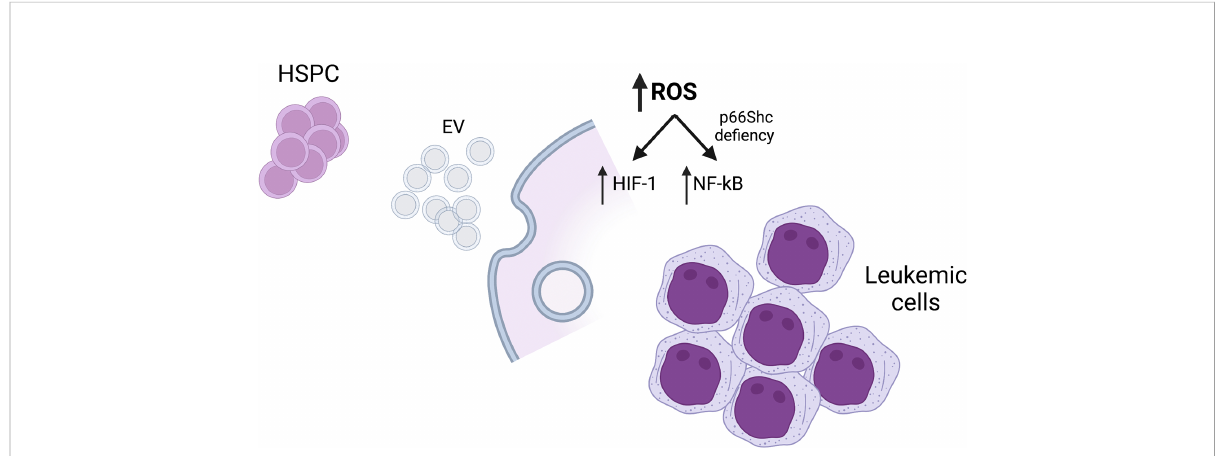
FIGURE 1 Mechanisms of cellular stress responses in blood malignancies. HSPC, hematopoietic stem/progenitor cells; EV, extracellular vesicles; ROS, reactive oxygen species. Created with